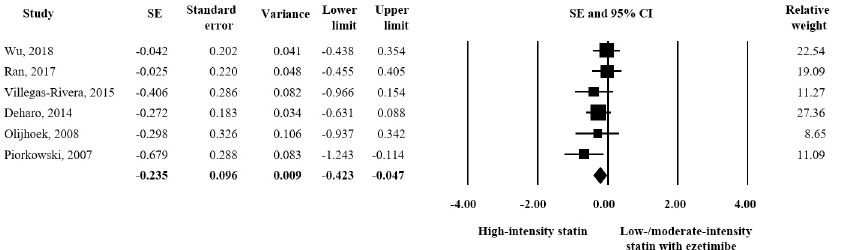
Fig 8. Forest plot of safety evaluation results. Changes in AST observed for high-intensity statin monotherapy and low/moderate-intensity statin plus ezetimibe combination therapy.